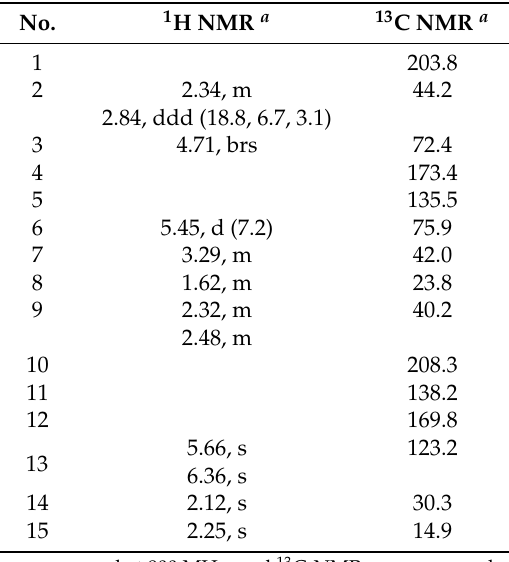
Table 1. 1 H- and 13 C-NMR data of compound 1 ( δ in ppm, J in Hz, CDCl 3 ).